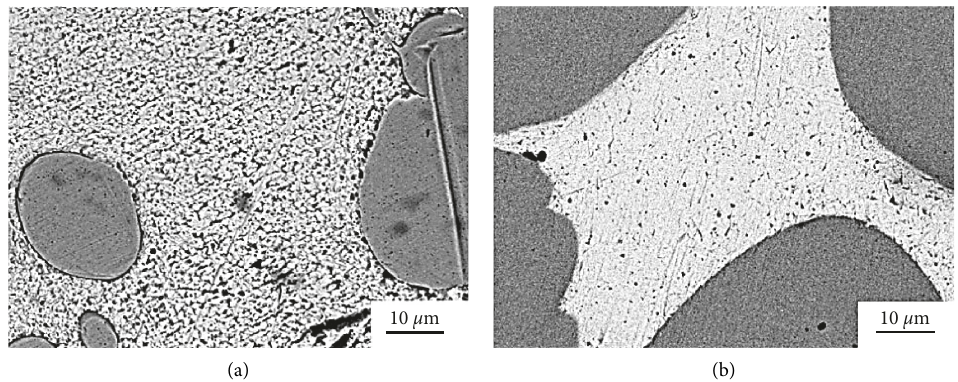
Figure 4: SEM photographs of CuCr alloy: (a) before and (b) after 1GPa high-pressure treatment [9].